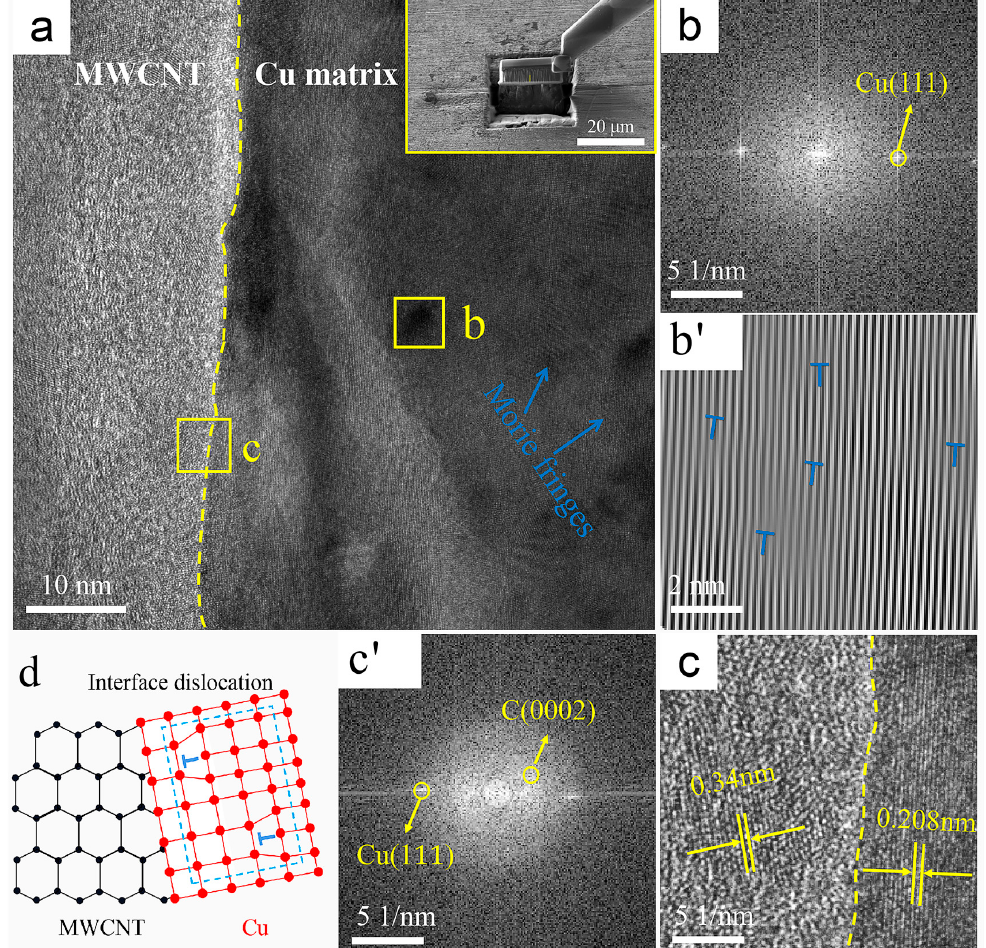
Figure 5. TEM images of the B-CNTs/Cu composite: ( a ) interface, upper right corner illustration shows manipulator sampling (Illustration is TEM sampling location); ( b ) FFT image of region b in ( a ); ( b’ ) IFFT image of region b in ( a ), with dislocations marked by “T” symbols; ( c ) enlarged view of region c in ( a ), and ( c’ ) is its FFT image; ( d ) schematic of interface dislocations. Figure 6 shows representative TEM images of the interface region of Cu@CNTs/Cu composites and the corresponding FFT and IFFT images. Through measurement of the crystal plane spacing in combination with the FFT patterns, three zones were recognized in Figure 6d’ The plane spacing below the yellow dotted line in Figure 6a,d was ~0.34 nm, which corresponds to the C(0002) lattice of MWCNTs. The crystal plane spacing above the red dotted line was ~0.209 nm, which corresponds to the Cu(1 1(cid:3364) 1) plane; the plane spacing between red and yellow dotted lines was ~0.246 nm, which corresponds to the Cu 2 O(111) plane. In addition, on the lower side of the yellow dashed line, region b, and region c in Figure 6d, we detected an interplanar spacing of ~0.213 nm, ~0.208 nm, and ~0.213 nm, corresponding to the Cu 2 O(200) plane, Cu( 1(cid:3364) 11) plane, and Cu 2 O(200) plane, respectively, and (0002) MWCNT //( 1(cid:3364) 11) Cu , demonstrating that the Cu was grown in situ at the interface. Therefore, it was determined that this Cu on MWCNTs originated from chemical plating. As for Cu 2 O, it may originate from a variety of factors: (1) oxidation of the electroless Cu coating. The oxidation may occur during the composite preparation process, such as stor- age, powder mixing, and sintering. (2) Cu reacted with oxygen-containing functional groups to form Cu 2 O. The acid treatment used in this work may have introduced oxygen- containing functional groups, e.g., carboxyl and hydroxyl groups on MWCNTs [47],